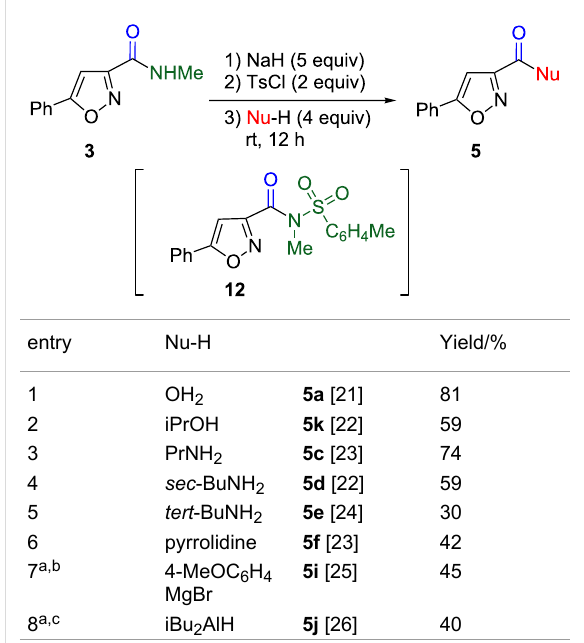
Table 3: Chemical conversion of N -methylisoxazole-3-carboxamide 3 .